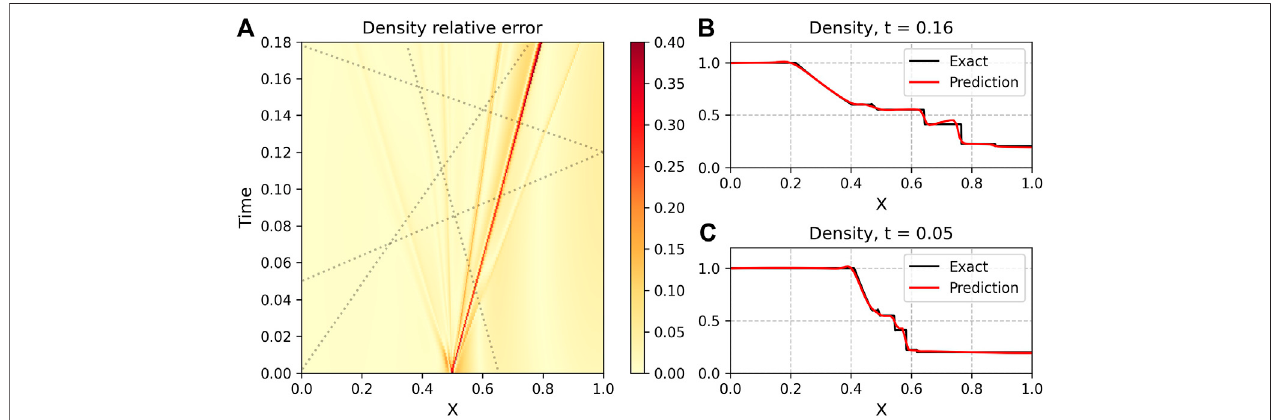
FIGURE6|(A) :DensityRelativeError (cid:3) ( ρ net − ρ )/ ρ (cid:3) foraPINNtrainedwithfoursampledtrajectories(dottedlines)ontheRyu-Jonesshocktube.Thegreatesterroris along the shock wave (second from right); the PINN does not handle abrupt gradients well. (B,C) : Exact (black) and NN-generated values (red) for ρ at t (cid:1) 0.2 (top) and t (cid:1) 0.05 (bottom). The PINN is able to reconstruct the state, but still has issues with sharp